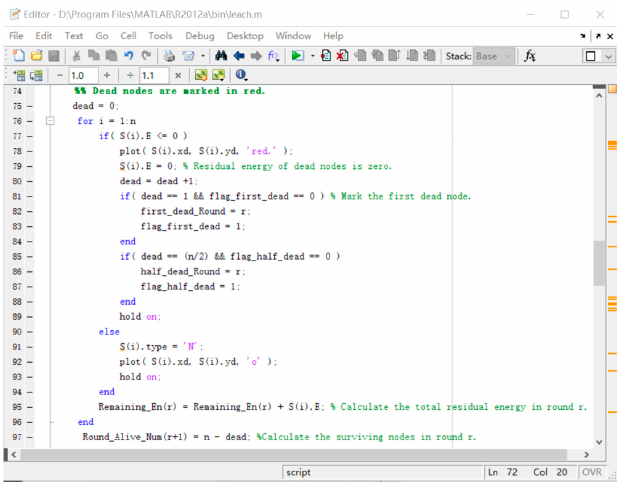
Figure 8. The code of calculating the nodes alive. Table 1. The simulation parameters.